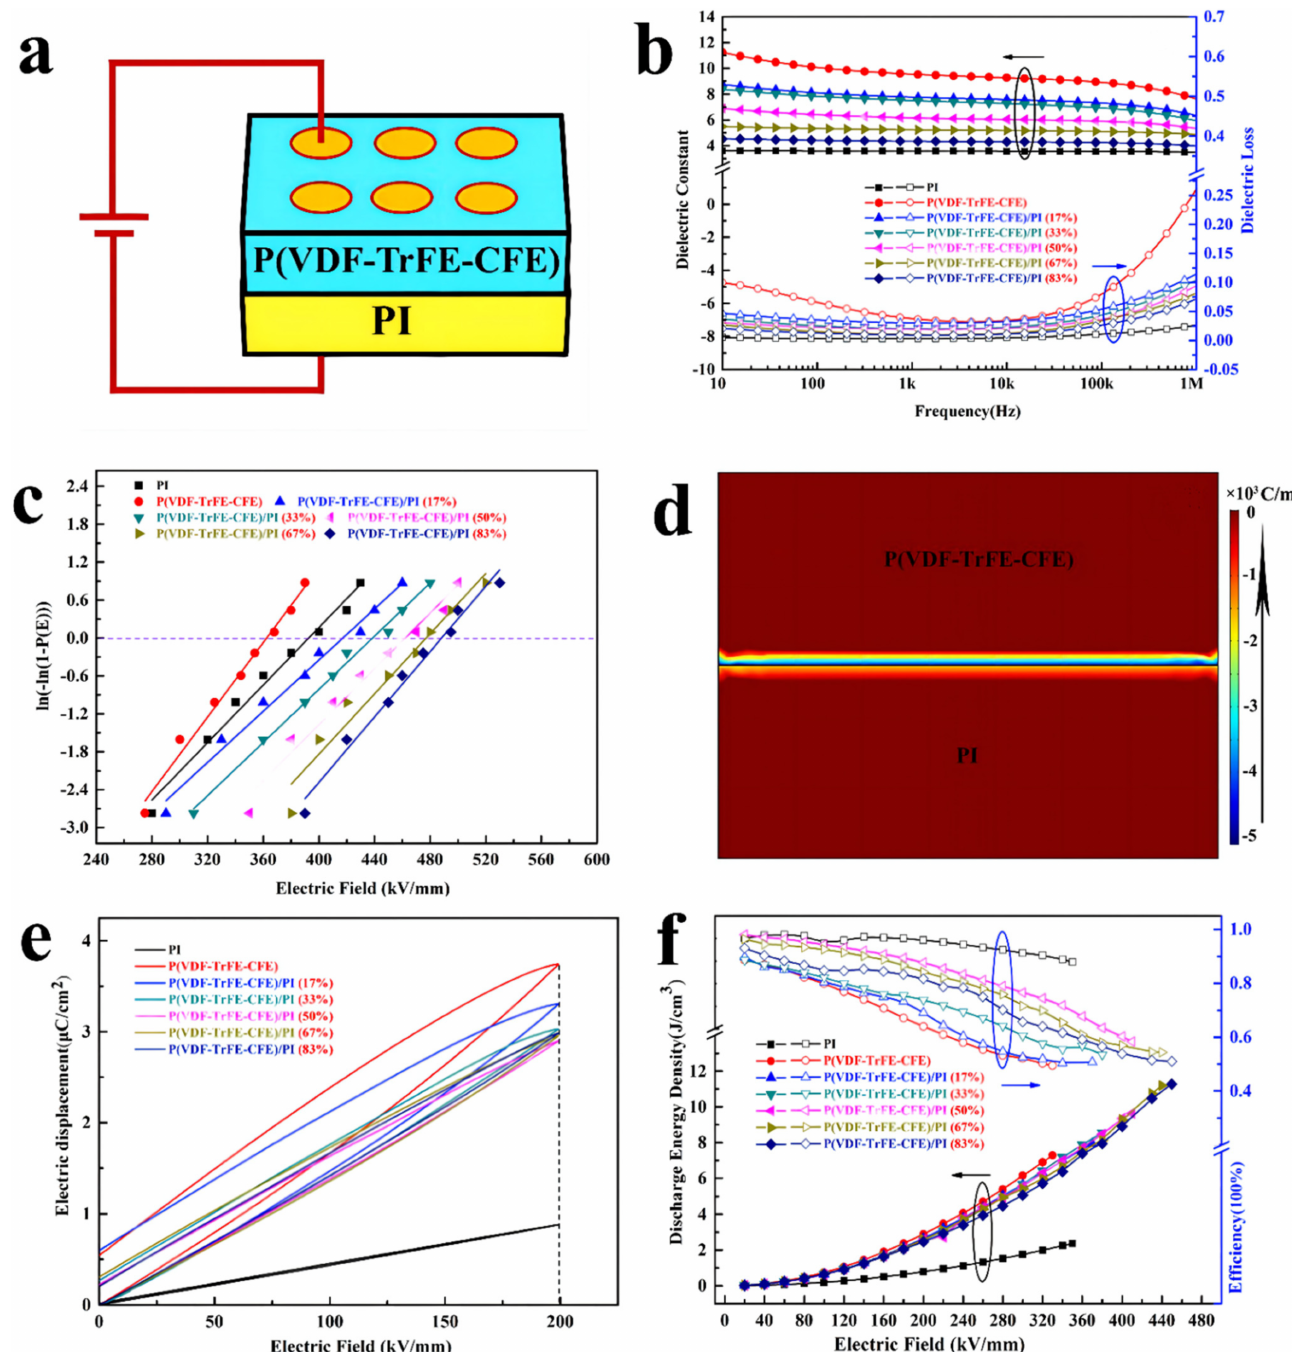
Figure 3. ( a ) Schematic diagram of P(VDF-TrFE-CFE)/PI bi-layered films. ( b ) Dielectric properties of P(VDF-TrFE-CFE)/PI bi-layered films: frequency-dependent changes of the dielectric constant and dielectric loss. ( c ) Weibull breakdown strength of P(VDF-TrFE-CFE)/PI bi-layered films. ( d ) The space charge density simulation for P(VDF-TrFE-CFE)/PI bi-layered films. ( e ) D − E loops of P(VDF- TrFE-CFE)/PI bilayer films with different PI volume ratios at an electric field of 200 MV m − 1 . ( f ) Relationship between the applied electric field and energy storage performances of P(VDF- TrFE-CFE)/PI bi-layered films. Adapted with permission from [31], Copyright © 2022 American Chemical